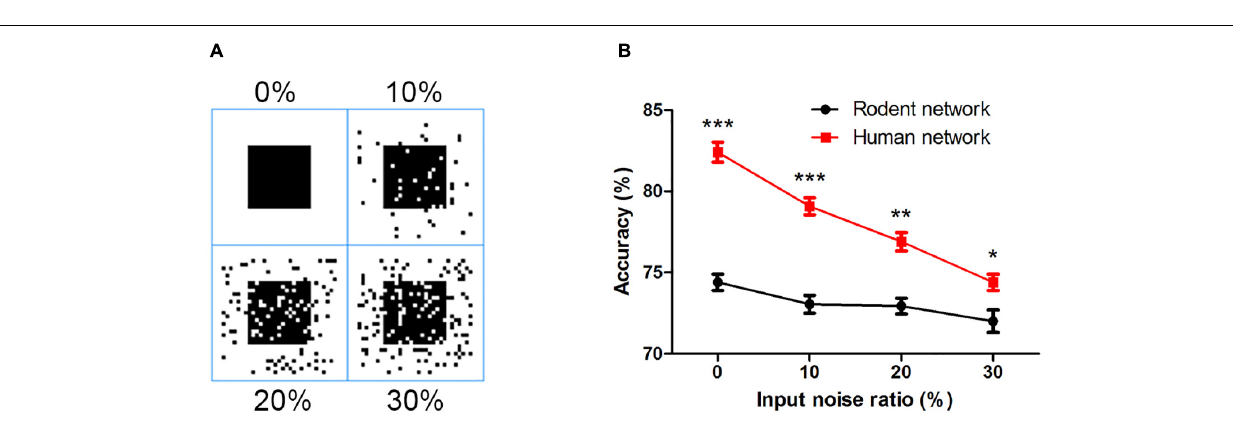
FIGURE 7 | (A) The input image with different proportions of salt and pepper noise. (B) The influence of salt and pepper noise on accuracy. The error bars represent the standard error of the mean of nine independent experiments, * P < 0.05, ** P < 0.01, *** P <